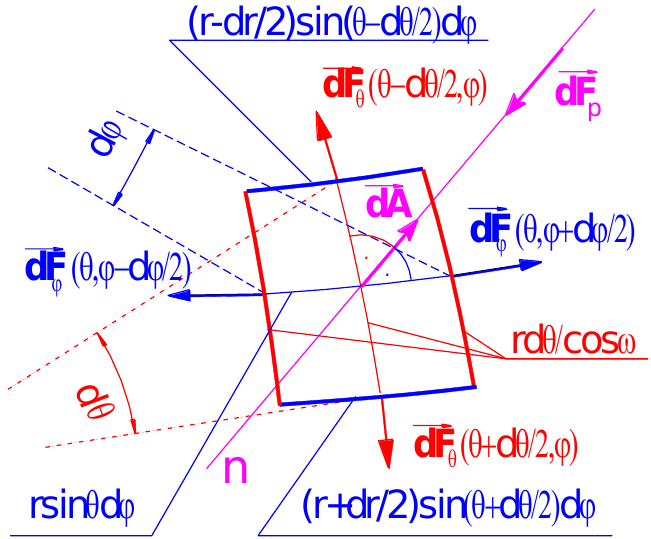
Figure 3. The enlarged infinitesimal surface area ( dA ) with the assumed force system, and the arc lengths.